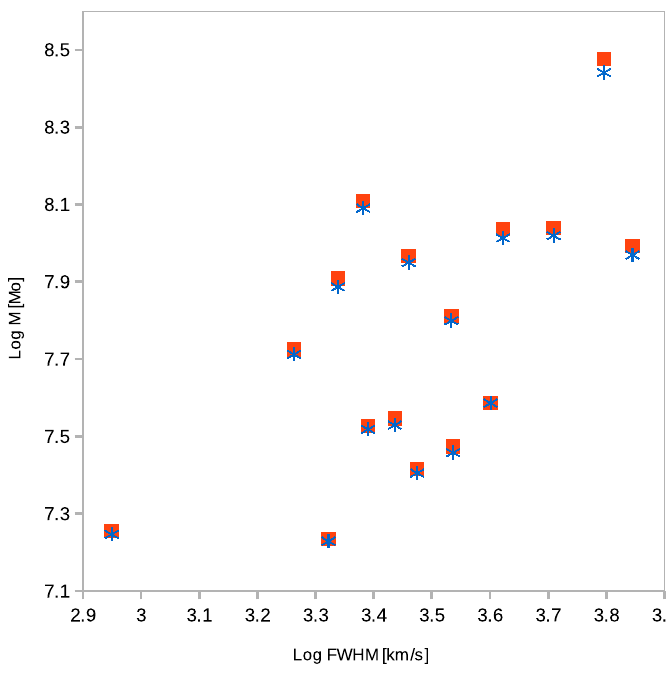
Figure 4. The Full Width at Half Maximum of H β line versus mass of central SMBH, calculated for each radius-period pair (orange squares and blue